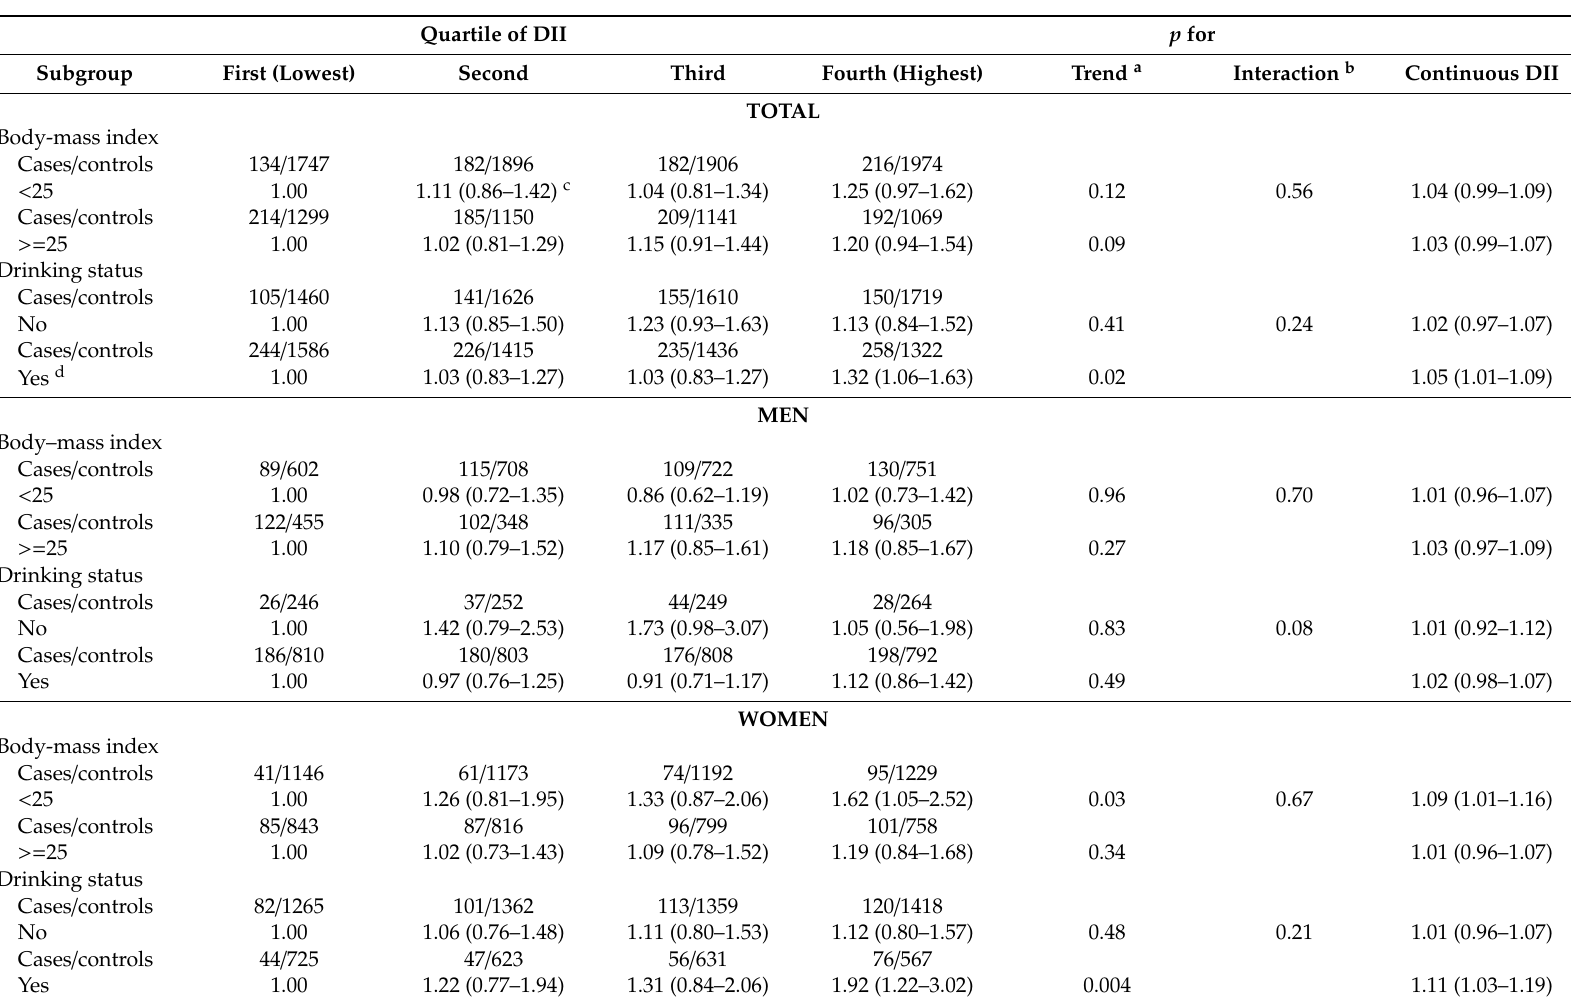
Table 3. Multivariable adjusted ORs of hyperuricemia and corresponding 95% CI by quartile of DII scores stratified by BMI, drinking in KoGES_CAVAS cohort. Quartile of DII p for Interaction